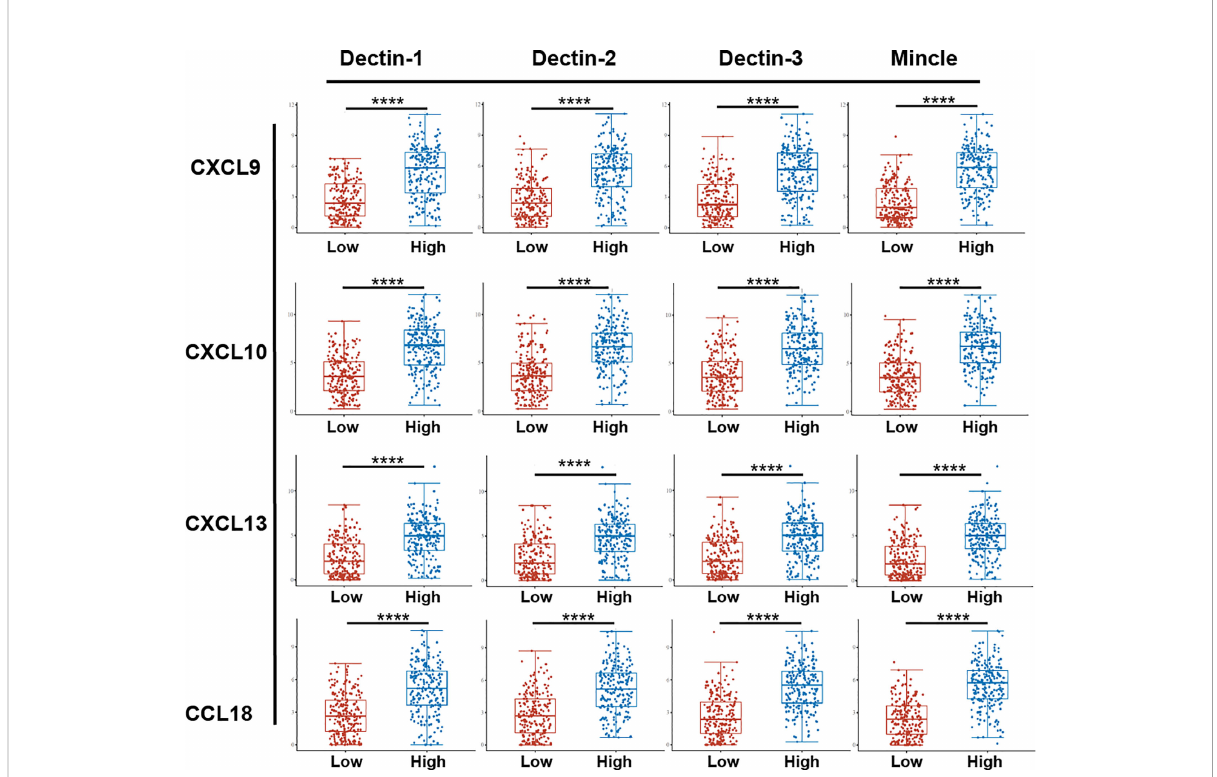
FIGURE 4 Comparison of speci fi c chemokines expression between bladder cancer patients in the CLR-low and CLR-high groups. The 406 bladder cancer patients from the TCGA database were divided into CLR-low ( n = 203) and CLR-high ( n = 203) groups according to whether the expression of CLR mRNA was above or below the median. The abscissa represents different sample groups and the ordinate represents the distribution of expression of CLRs; different colors represent different groups. * p < 0.05, ** p < 0.01,*** p < 0.001, ****p < 0.0001. The statistical differences between the two groups were compared using a Wilcox